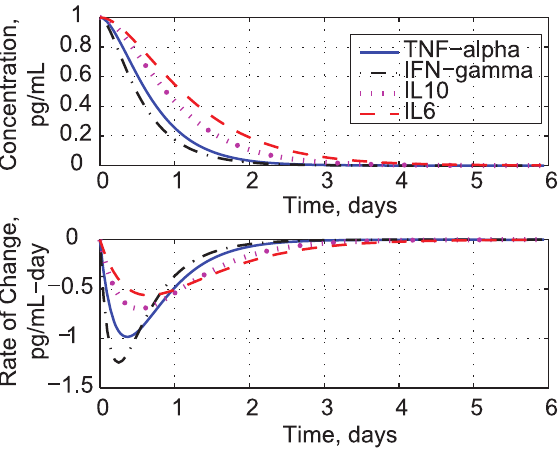
Figure 3. Response to unit initial concentrations for TNF- a , IFN- c , IL10, and